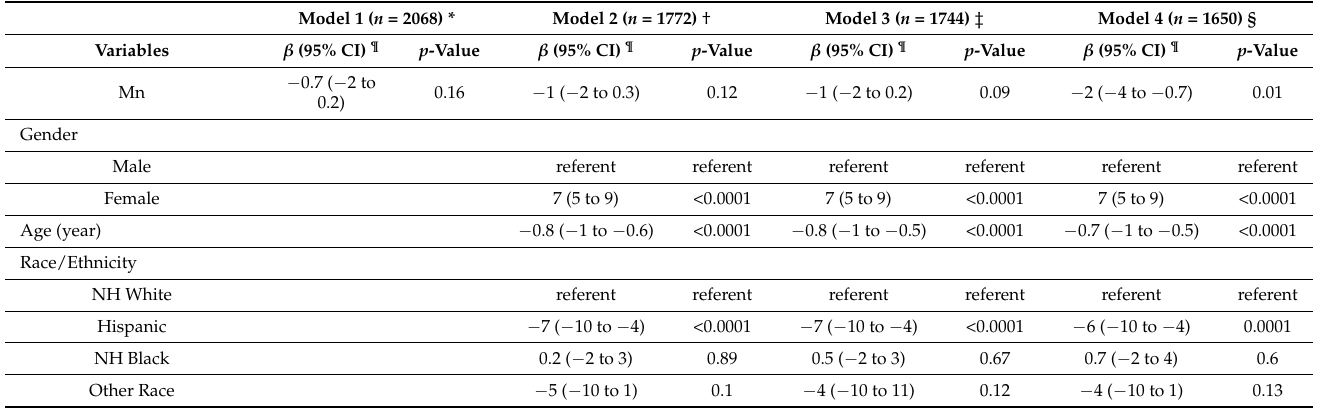
Table 5. Mn-Urine levels (continuous) in relation to CERAD